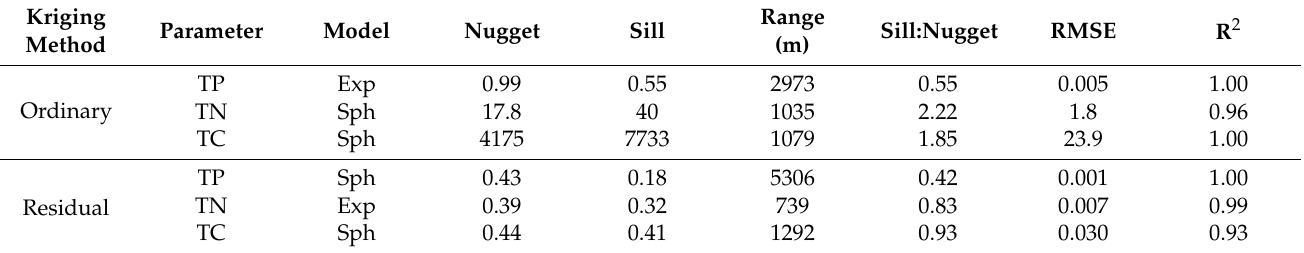
Table 5. Semivariogram parameters and kriging prediction error statistics for soil total phosphorus (TP), total nitrogen (TN), and total carbon (TC) using ordinary and residual kriging. Semivariogram model abbreviations: Sph, spherical model; Exp, exponential